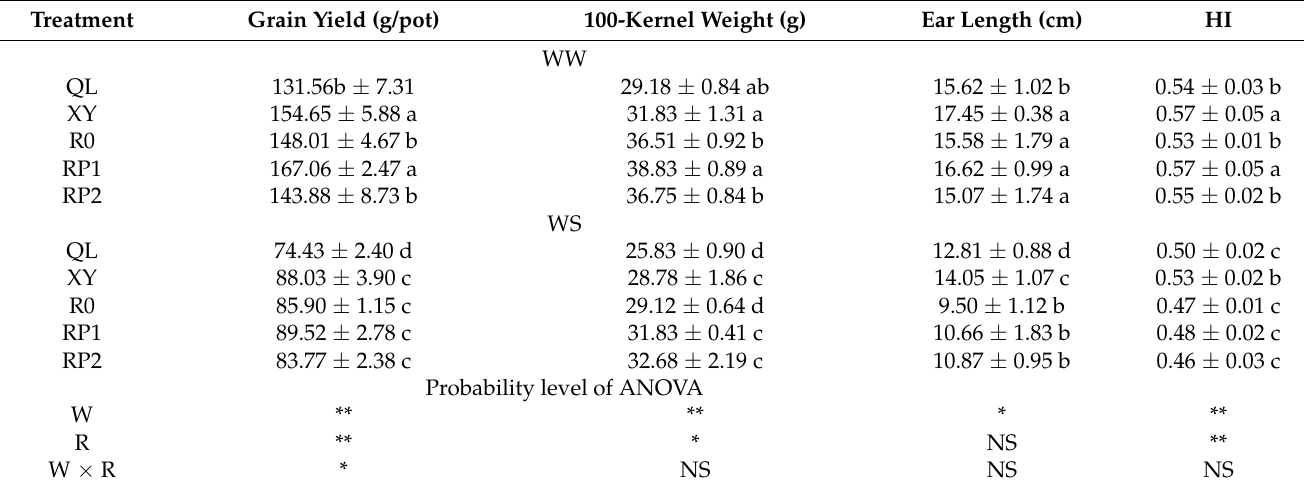
QL (large root variety), XY (small root variety), R0 (no root pruning), RP1 (small root pruning), and RP2 (large root pruning) under well-watered (WW) and drought stress (WS) conditions. Values are the means ± standard error ( n = 6). Different letters indicate significant differences among treatments ( p < 0.05) based on Duncan’s test. ANOVA results for the main factors (water, W; root size, R) and their interactions (W × R) are given for each parameter. Symbology: *, p < 0.05; **, p < 0.01; NS, not significant.